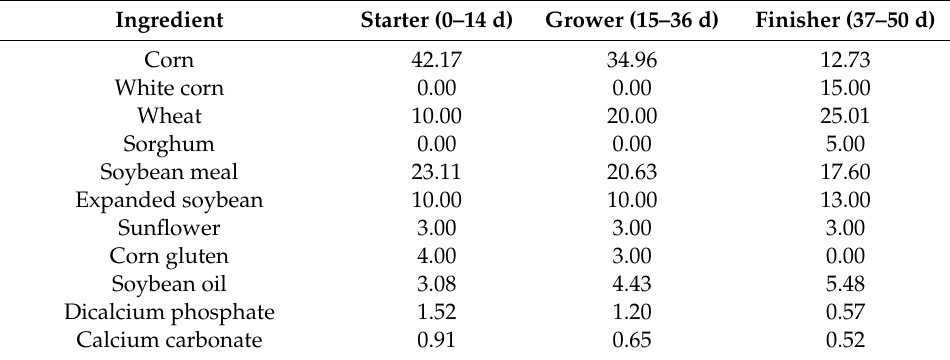
Table 1. Dietary formulation supplied in slow-growing chickens during three feeding